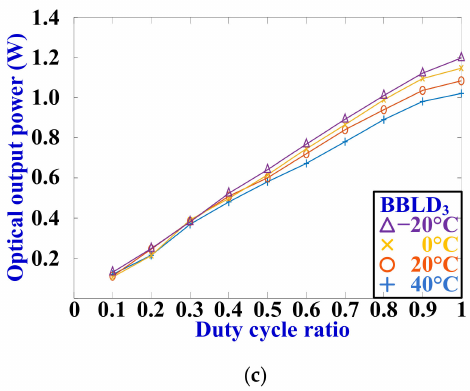
Figure 19. OOP ( P op ( pdcm ) ) variations of PDCM in frequency of 100 Hz. ( a ) BBLD 1 . ( b ) BBLD 2 . ( c ) BBLD 3 . When D pdcm was adjusted from 10% to 100% and the temperature was changed from − 20 ◦ 40 C, the forward-bias voltage RMS values of the BBLDs were increased, resulting in an increase in electrical powers, as shown in Figure 20.